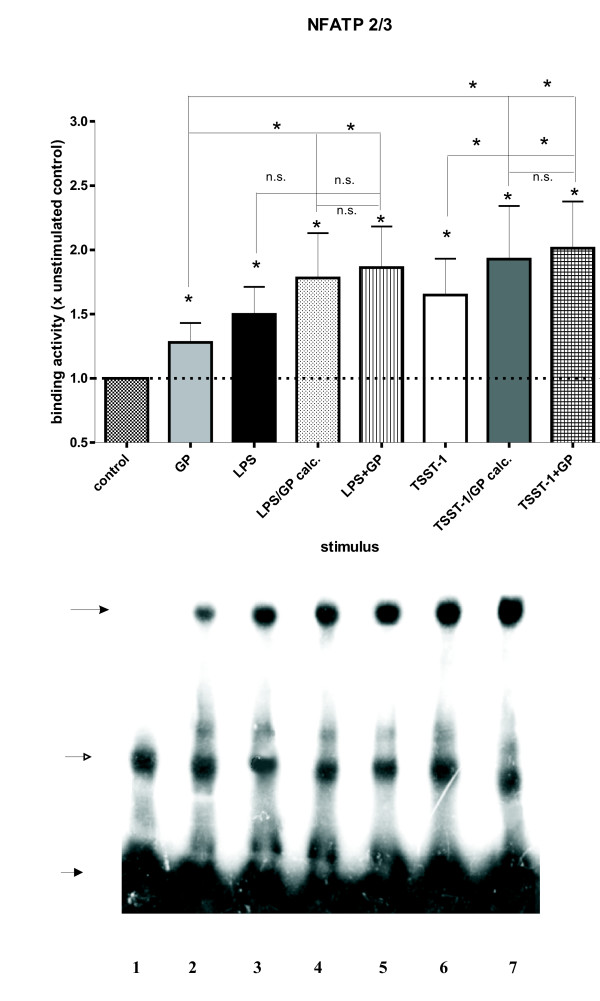
GP modulated TSST-1-induced DNA binding to a new NFATP2/3 site in the IL-1RA promoter. Binding was up-regulated for GP + LPS and GP + TSST-1, when compared to GP and, in the latter case, to both GP and TSST-1 (* = p < 0.05). Human PBMC were incubated with medium control, LPS, TSST-1, GP, GP + TSST-1 and GP + LPS for 1 h at 37°C. Schematic representation of the elevated NFAT-DNA binding activity to the site in the IL-1RA promoter. Bars depicting the theoretical values for GP/LPS calc. and GP/TSST-1 calc. are added. Medium control levels were set equal to 1 ± SEM (n = 6). An autoradiogram of a representative experiment is shown in the lower panel (lane 1: water; lane 2: medium control; lane 3: GP; lane 4: LPS; lane 5: TSST-1, lane 6: GP + LPS; lane 7: GP + TSST-1).